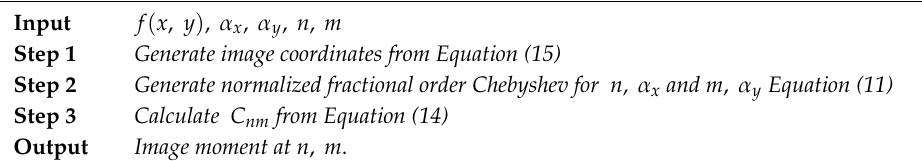
Algorithm 1: Orthogonal Fractional Chebyshev Moments